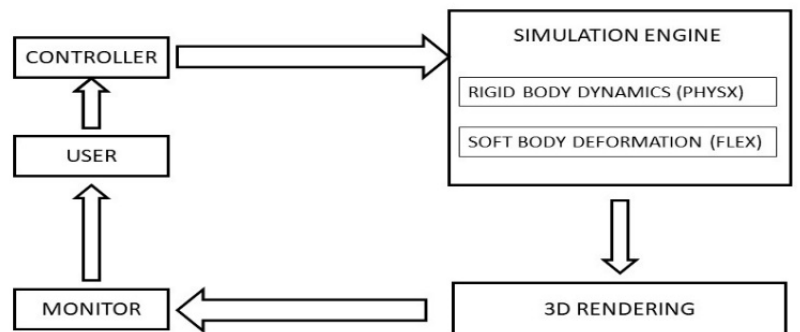
Figure 1. Simulator system diagram.